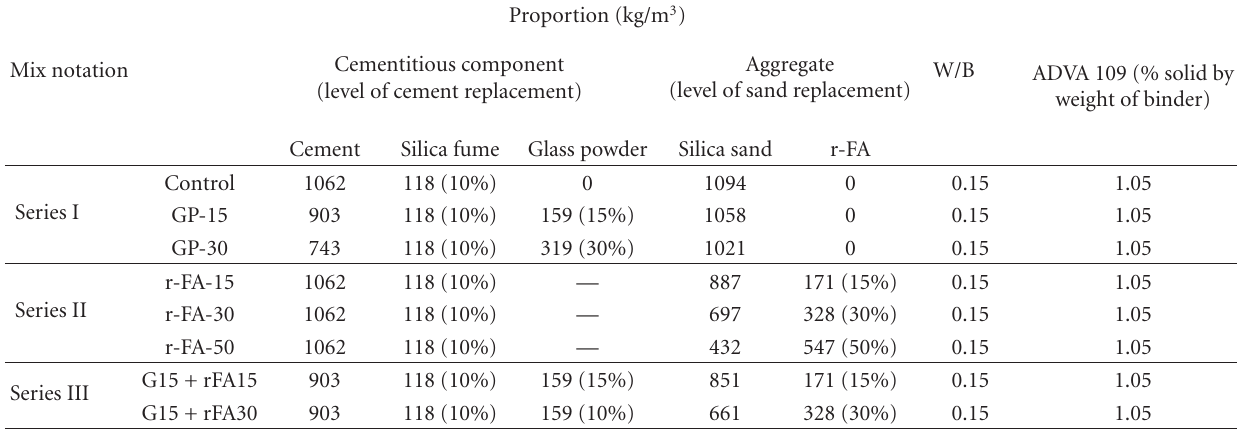
Table 3: Mix proportion of UHPFRC.